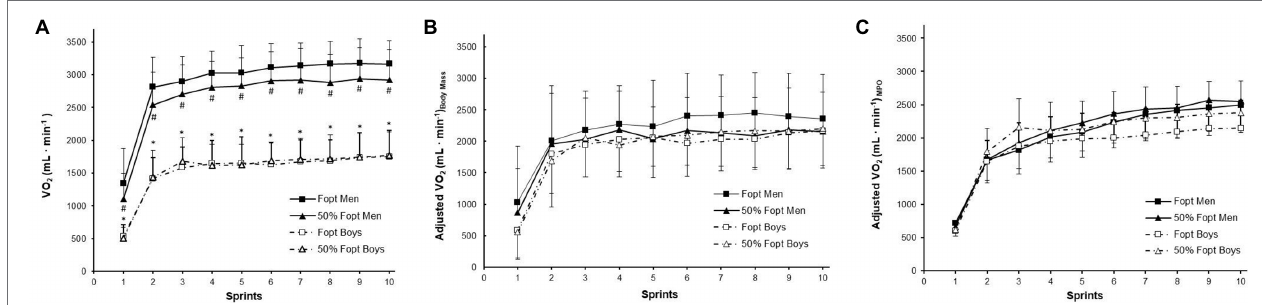
FIGURE 2 | Oxygen uptake response to 10 repeated cycling sprints at light and heavy resistive loads in boys and men. VO 2 in (A) absolute values, ml min − 1 , (B) adjusted for body mass, and (C) adjusted for mean power output (MPO). *Significantly different between boys and men in the heavy-load condition; p < 0.05. # Significantly different between boys and men in the light-load condition; p < 0.05.